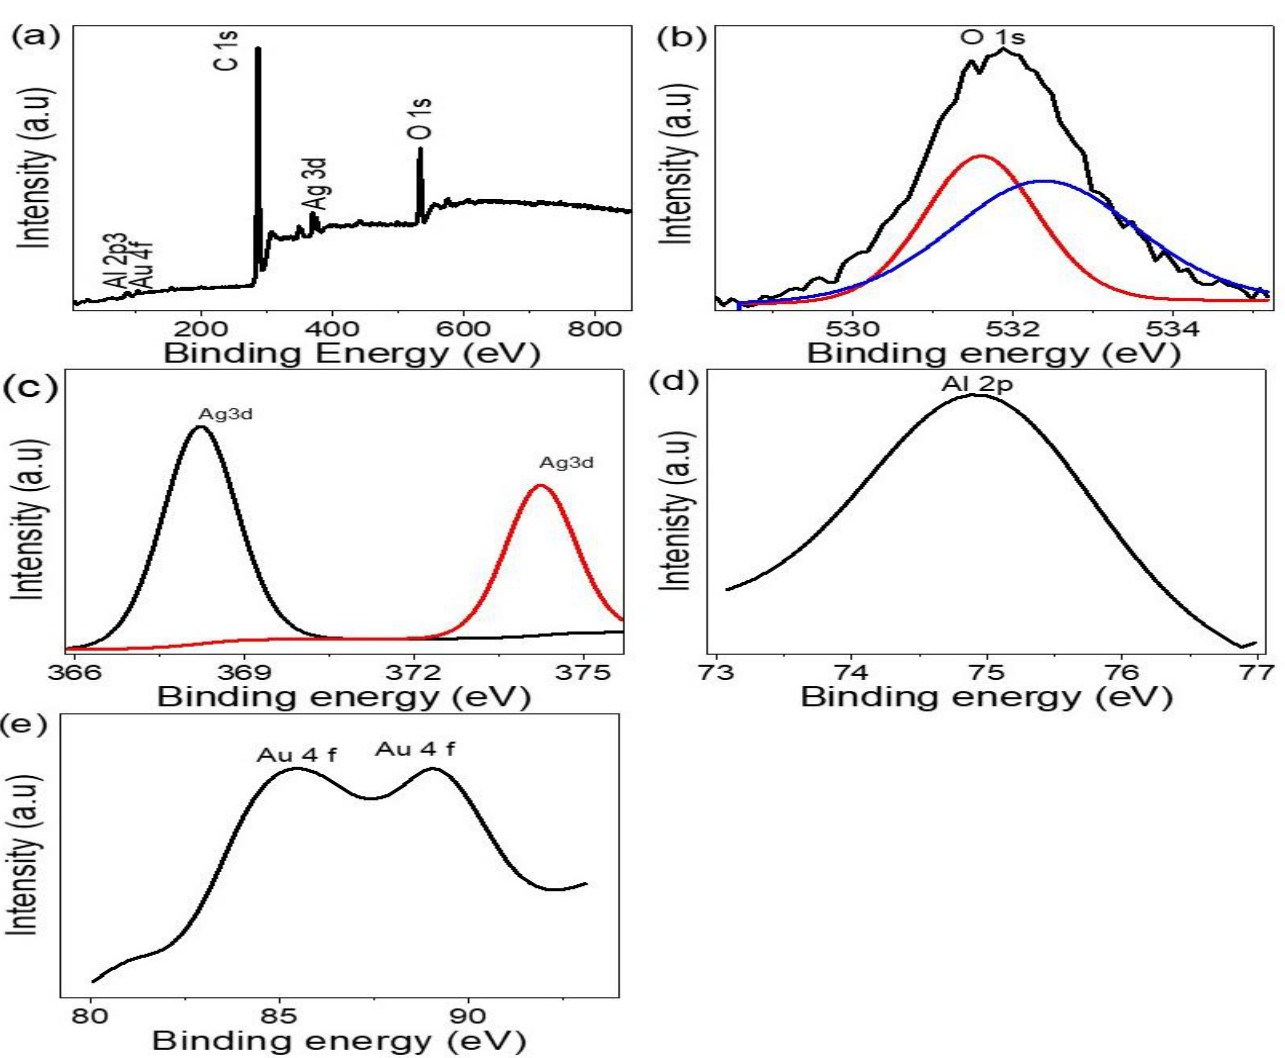
Figure 3. XPS analyses ( a ) survey, ( b ) O element, ( c ) Ag element, ( d ) Al element, and ( e ) Au element for the prepared Ag 2 O-Ag/Au/Al 2 O 3 nanomaterials. for the prepared Ag 2 O-Ag/Au/Al 2 O 3